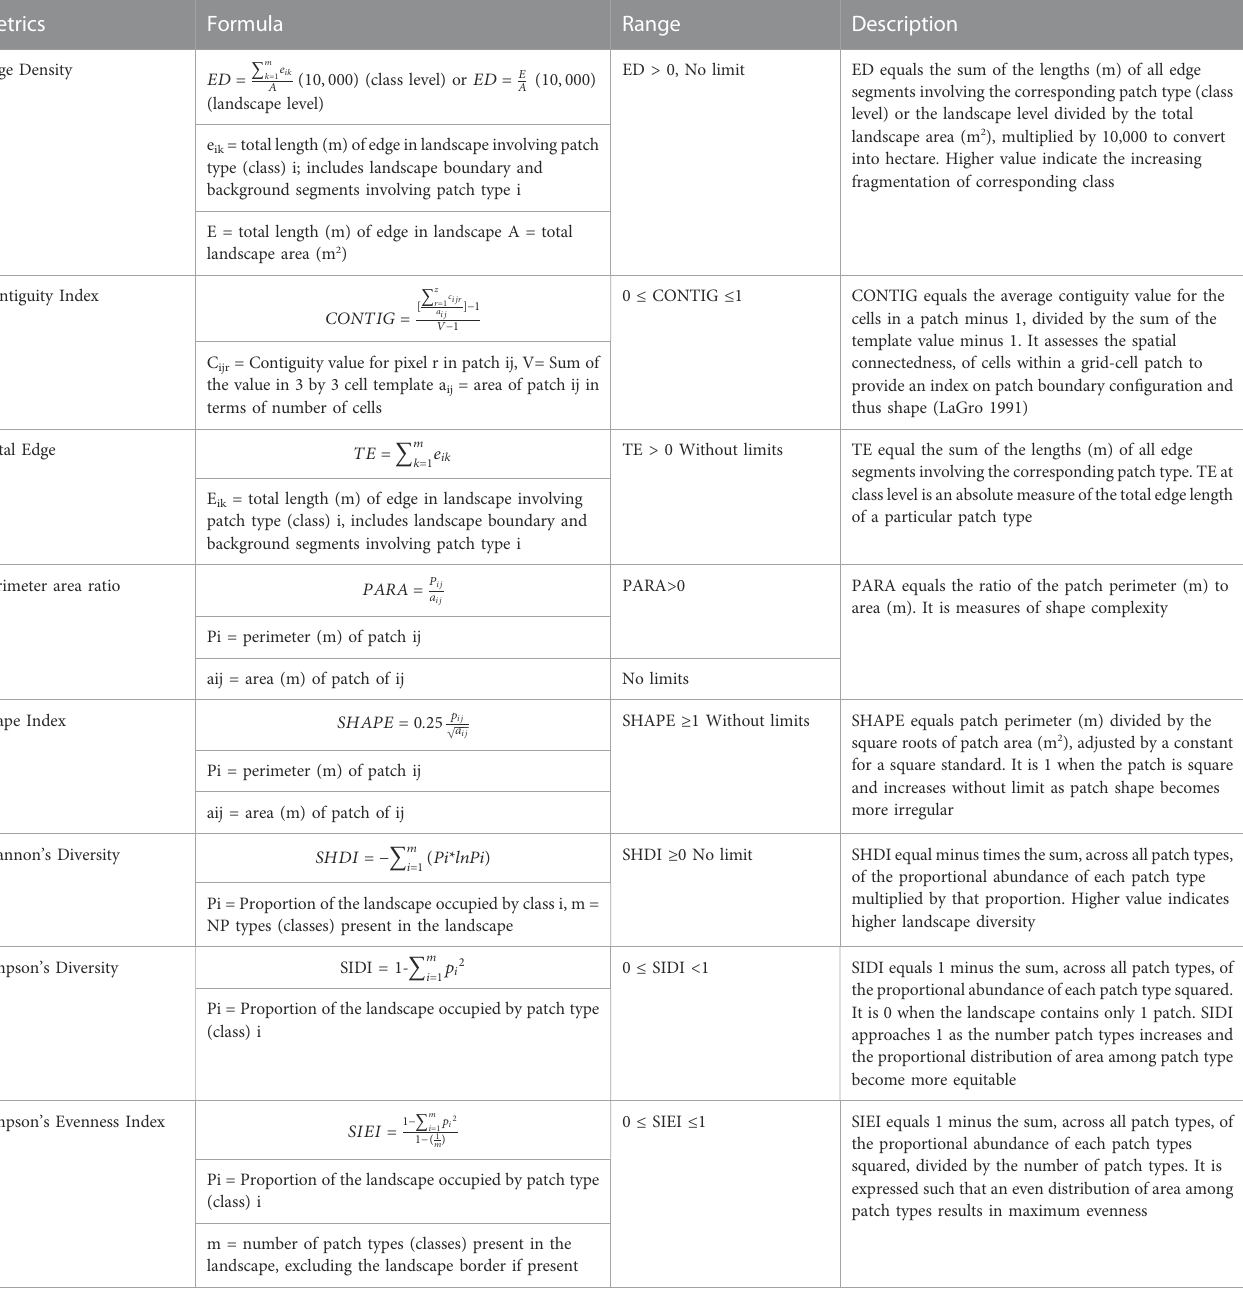
TABLE 2 Details of class and landscape level metrics used in the study, following (McGarigal, 2015).